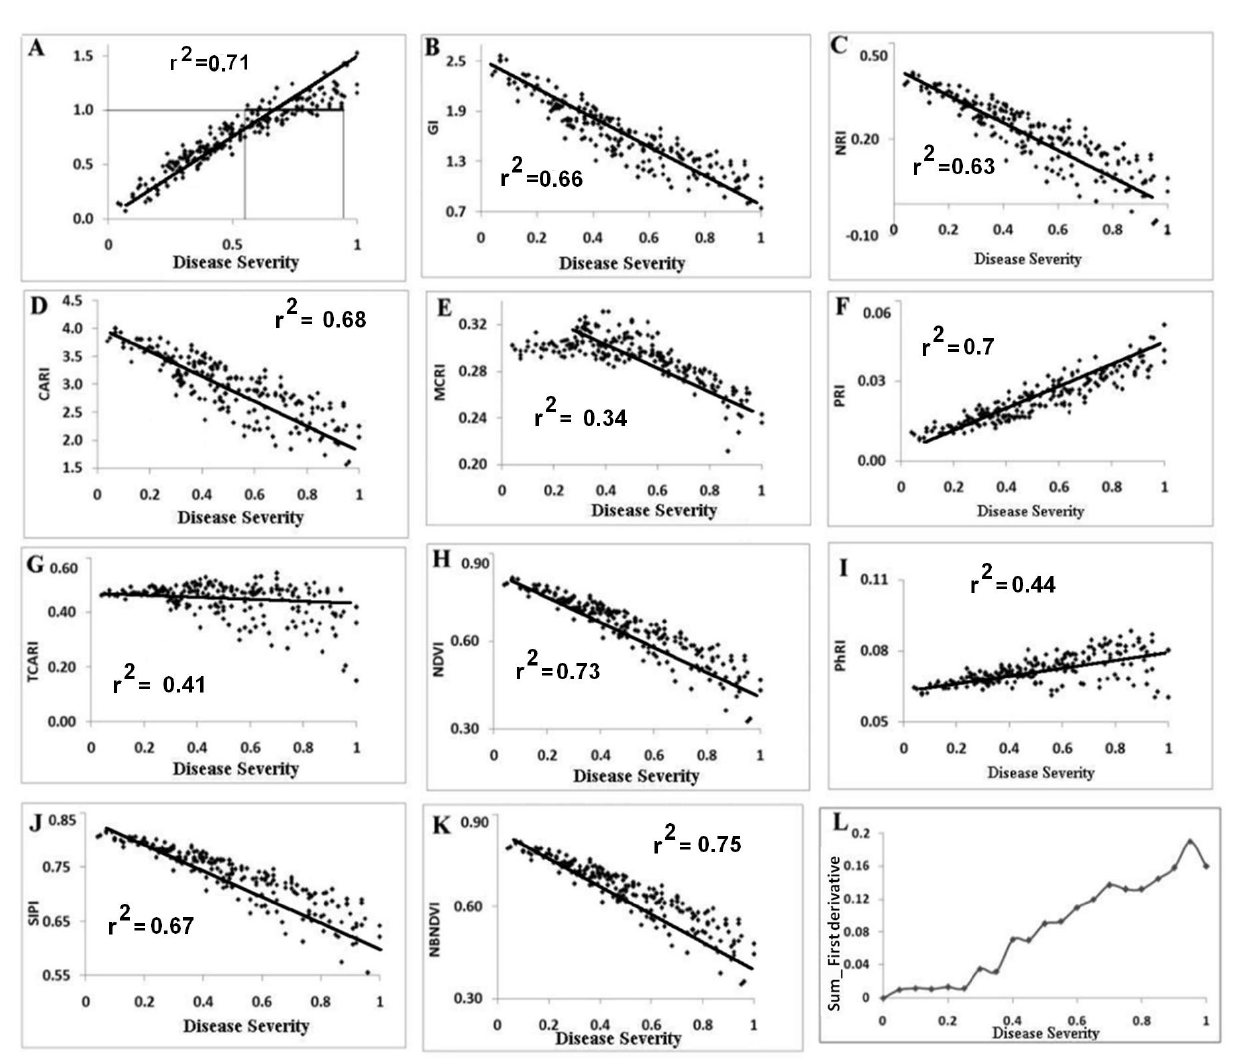
Figure 6. The relation between spectral features and the disease severity ( A to K ).Changes of first derivative sums and the disease severity in the same direction ( L